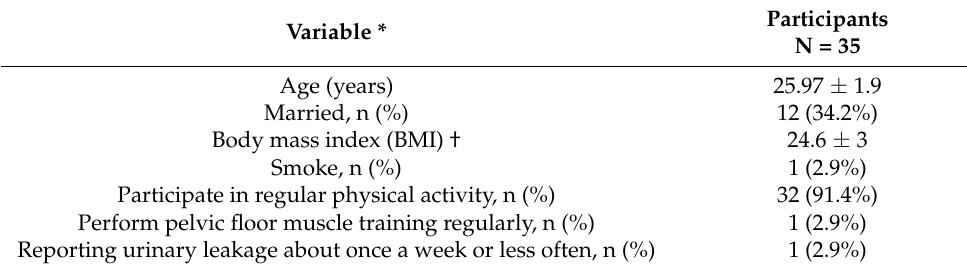
Table 1. Baseline demographic and clinical characteristics of participants.